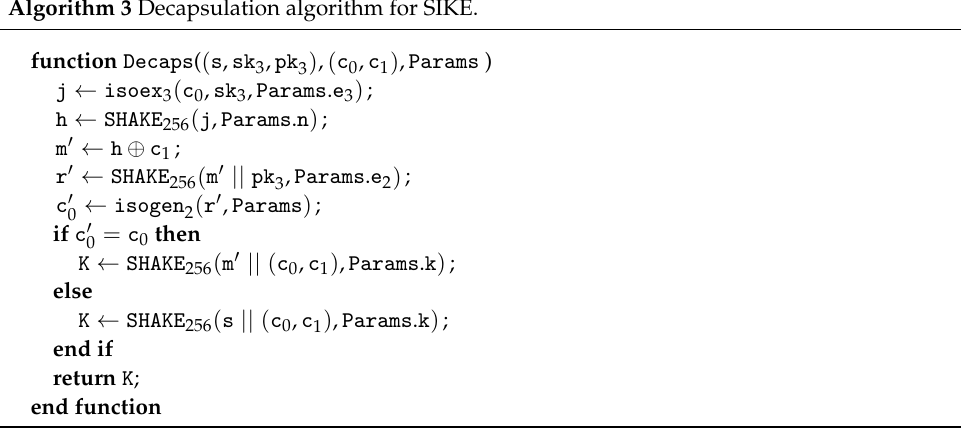
Algorithm 3 Decapsulation algorithm for